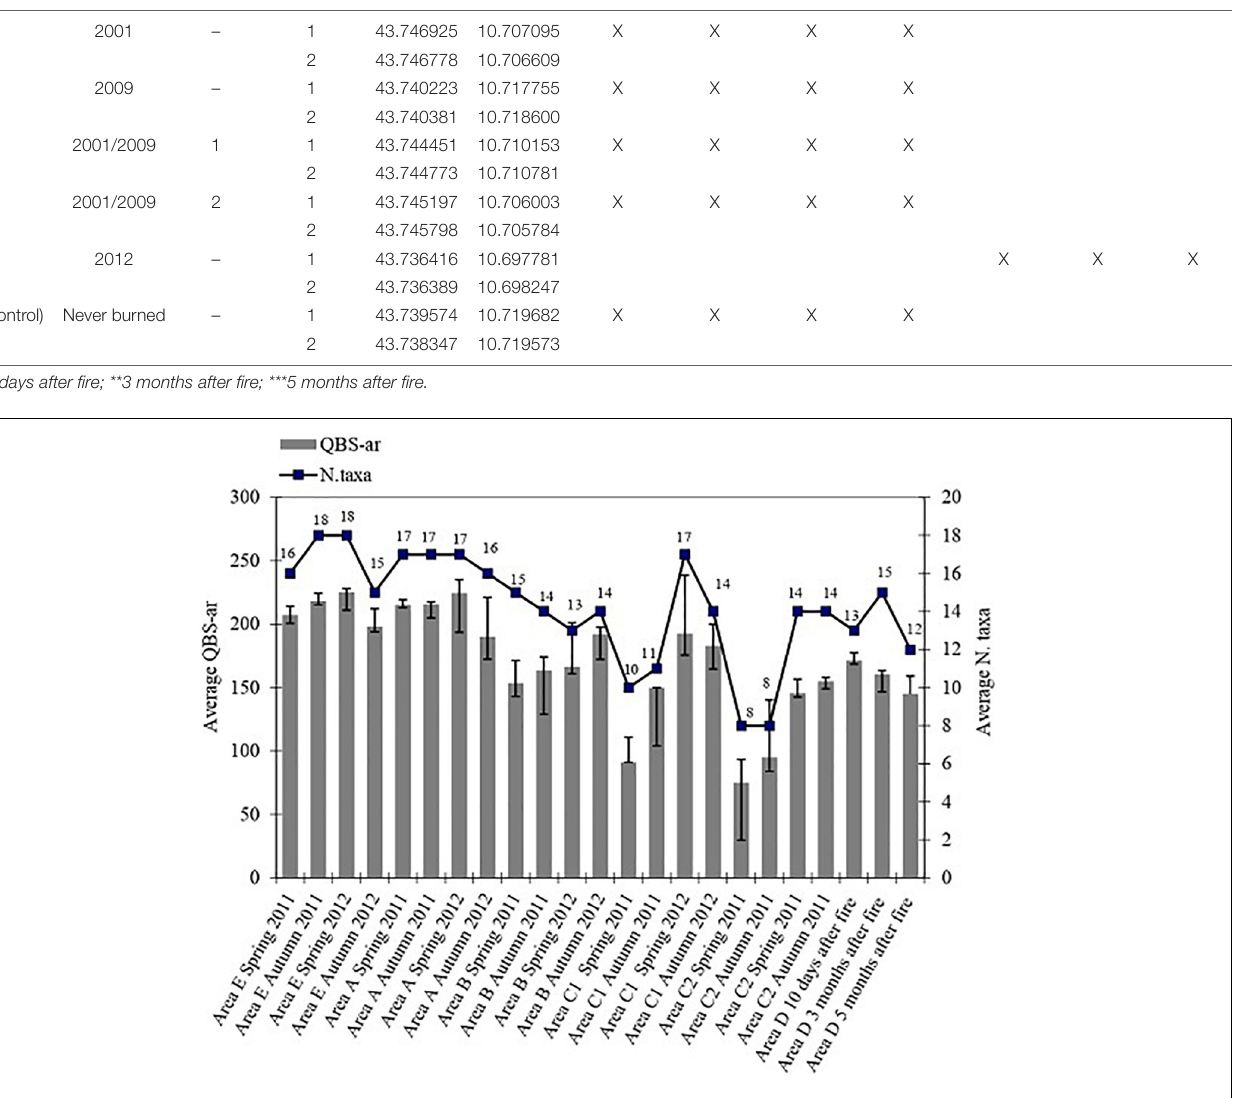
subphylum is represented by Araneae, Pseudoscorpiones and Acari, while Isopoda (1 taxon) and Tracheata (19 taxa) represent the Mandibolata